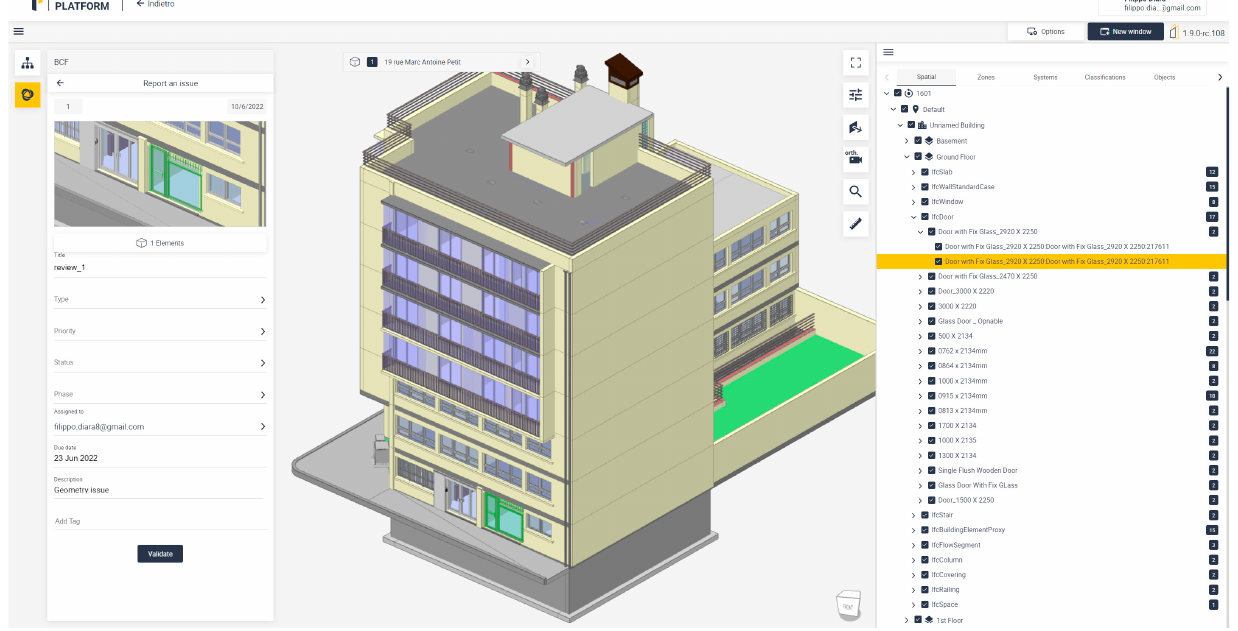
Figure 10. BIMData platform: detail of the sample model inside the 3D viewer. On the right side the properties tree; on the left the BCF plugin for generating